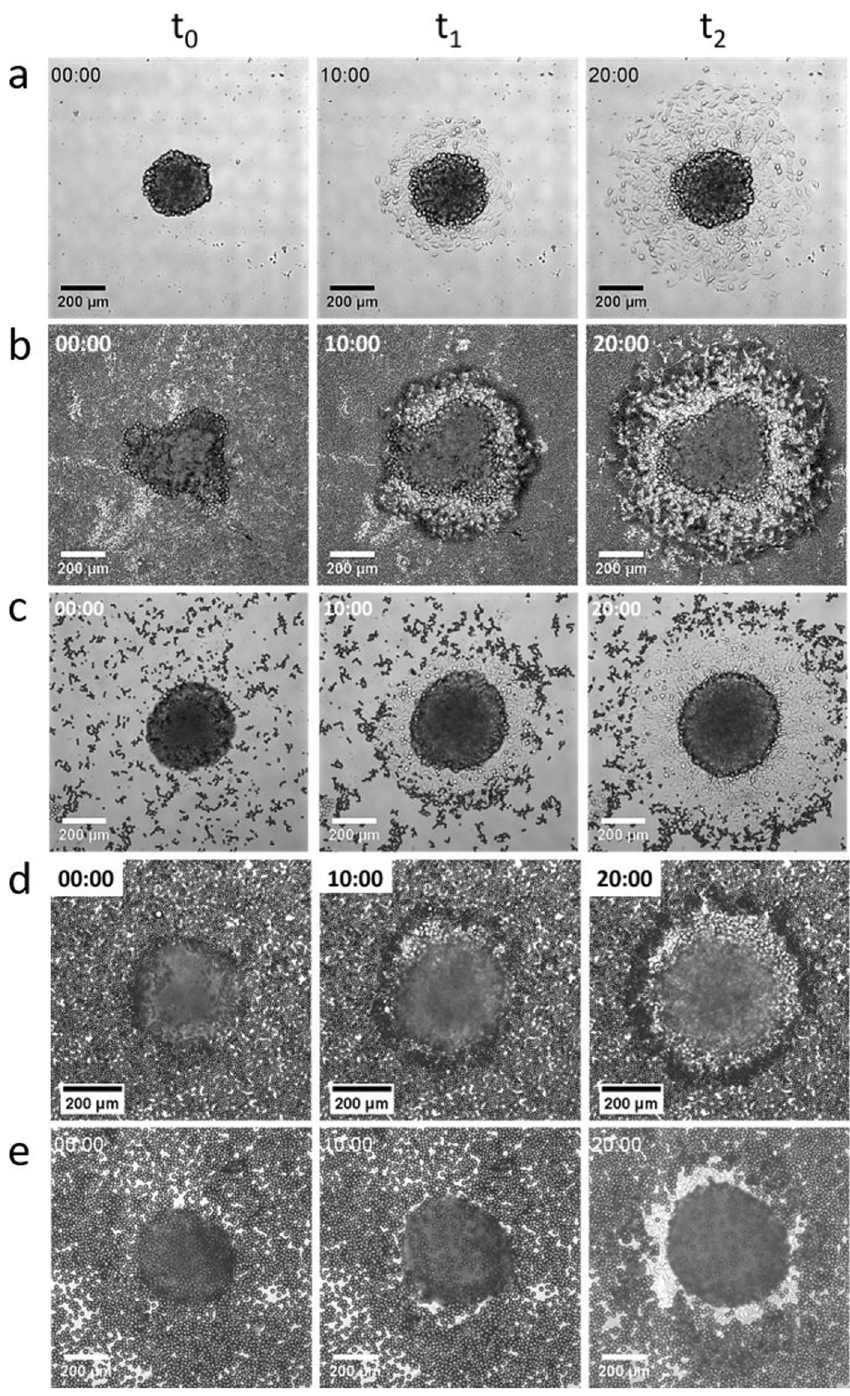
Fig. 1 Cellular aggregates spreading on substrates coated with light polystyrene microparticles. Time-dependent behavior observed in bright- fi eld images of cell aggregates. Aggregates are deposited on ( a ) a substrate without microparticles (MPs); decorated with polystyrene MPs: b Ps-4.5 with surface fraction Φ S = 0.25, c Ps-10 with Φ S = 0.13, d Ps-10 with Φ S = 1.02, and e Ps-20 with Φ S = 1.02. Cellular aggregates are the spherical structures in the middle. They spread forming a precursor fi lm made of elongated cells around. MPs are the dark spheres around the precursor fi lm. Time is measured in